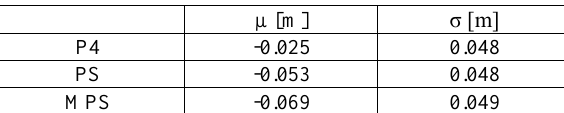
Table 2. Means and standard deviations of the DTM